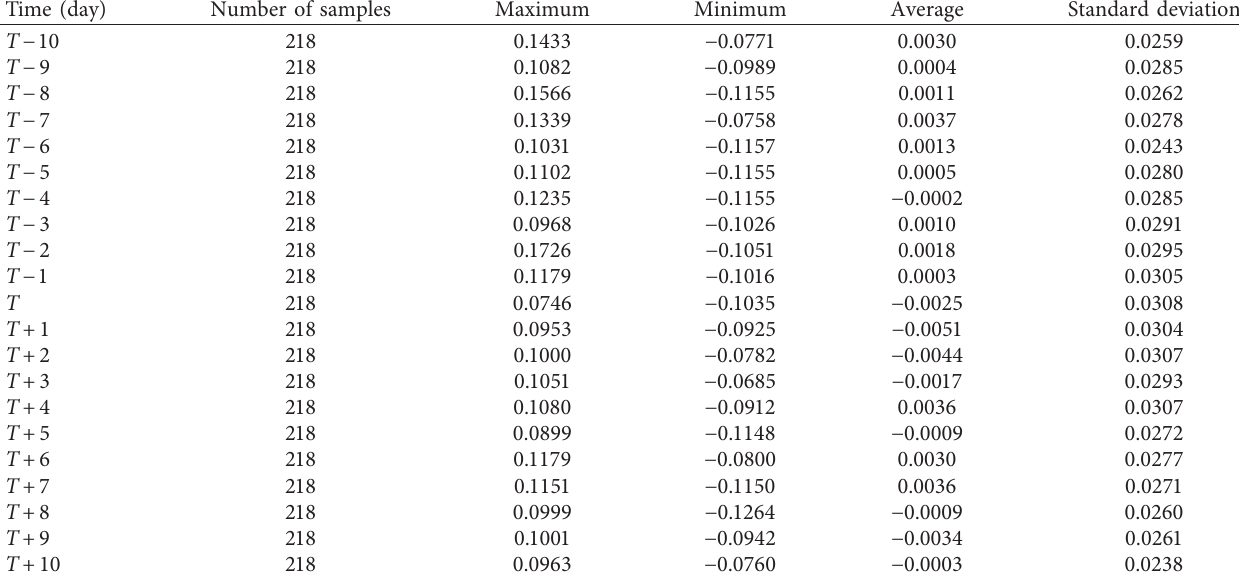
Table 2: Descriptive analysis of abnormal returns.